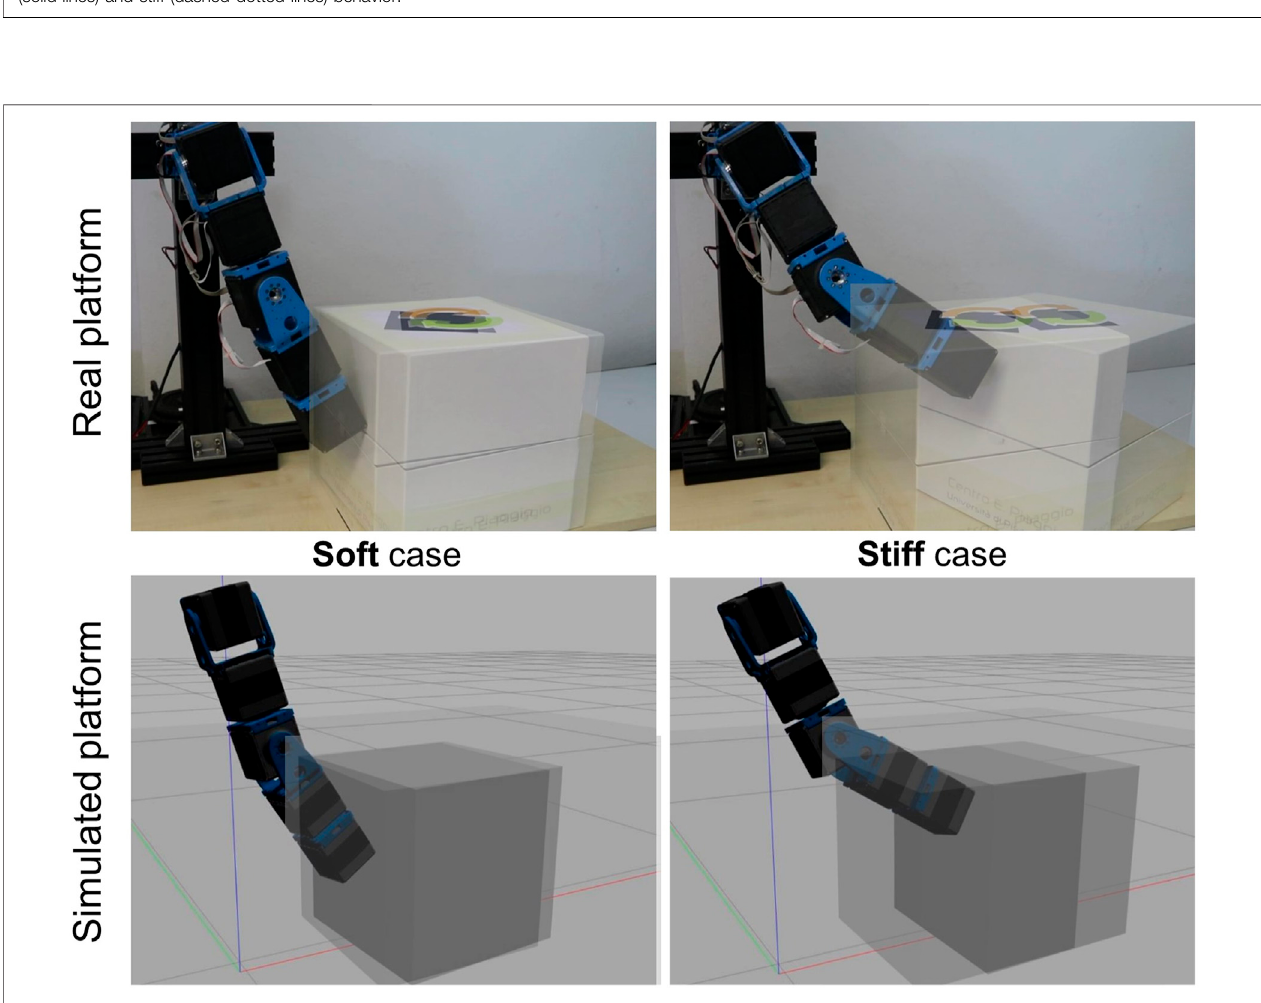
Frontiers in Robotics and AI |